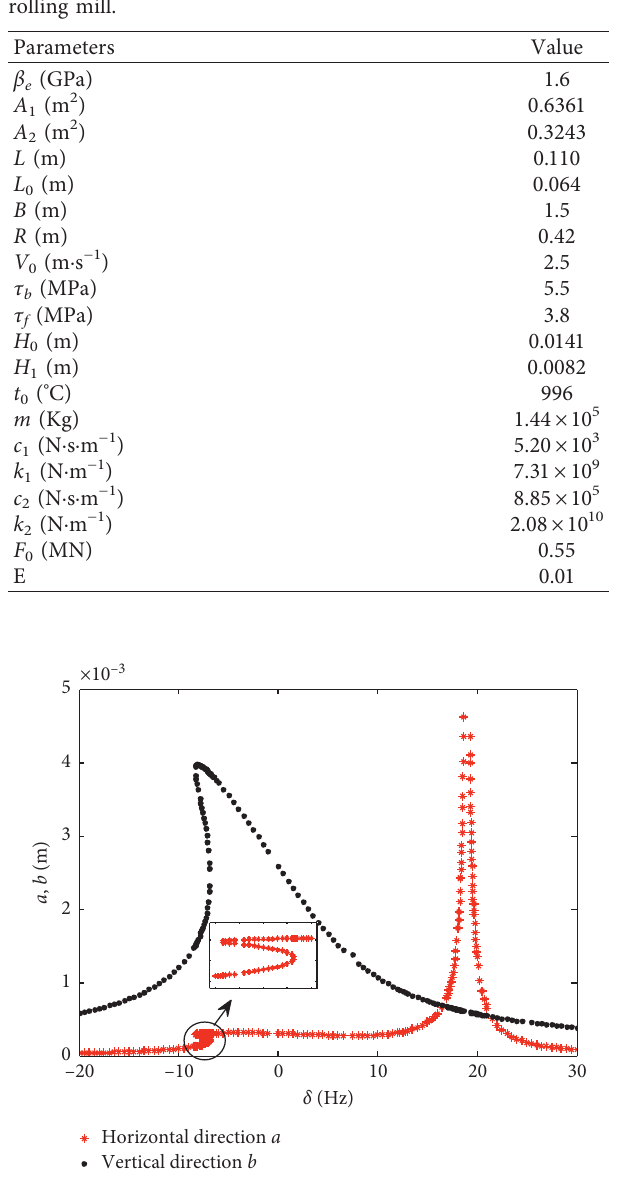
Figure 7: Amplitude-frequency curve of coupling vibration of the hot rolling mill roll